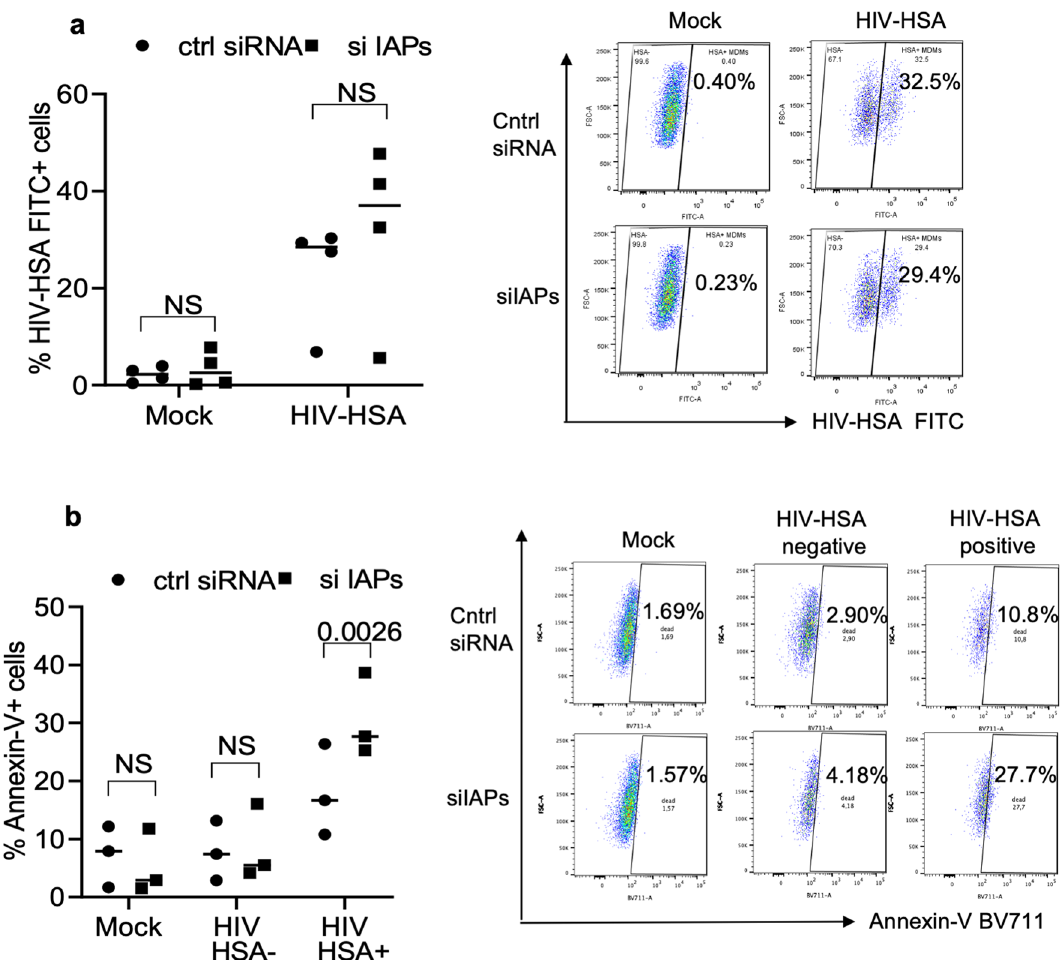
Figure 4. IAP siRNAs specifically induce cell death of HIV-HSA-infected MDMs. MDMs were in vitro infected with HIV-HSA for 7 days. The cells were transfected with non-targeting control siRNA or IAPs siRNAs. ( a ) After 72 h of transfection, degree of infection was assessed by anti-CD24 (HSA) antibody staining (left panel). Representative scatter plots show HIV-HSA FITC + cells (right panels). ( b ) After 72 h of transfection, cell death of mock, HIV-HSA− and HIV-HSA+ cells were detected by Annexin-V-BV711 and flow cytometry (left panel) (n = 4). Representative scatter plots show annexin-V-BV711 + cells (right panel). The p -values were calculated using two-tailed Mann Whitney U